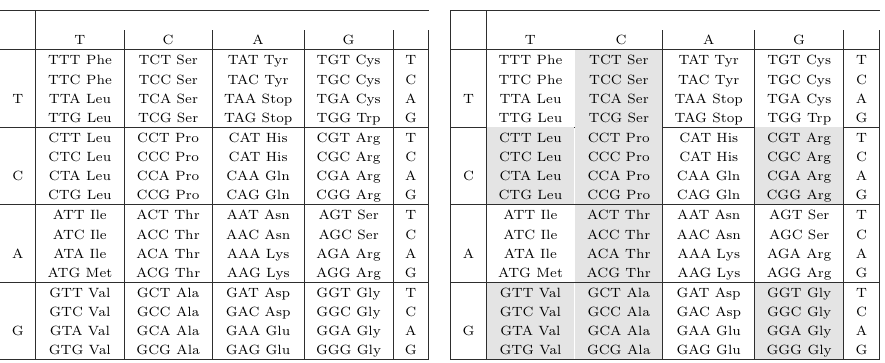
Figure 1 – (left) representation of the standard nuclear genetic code; (right) graphical representa- tion of the classification of triplets in Rumer’s classes. White boxes indicate triplets belonging to the class { 4 } , grey boxes indicate triplets belonging to the class { 1,2,3 }